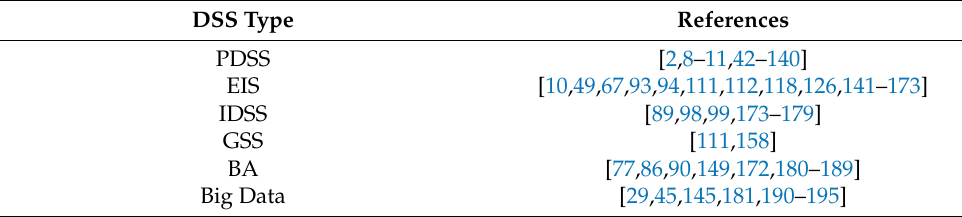
Table 8. Classification of articles by DSS